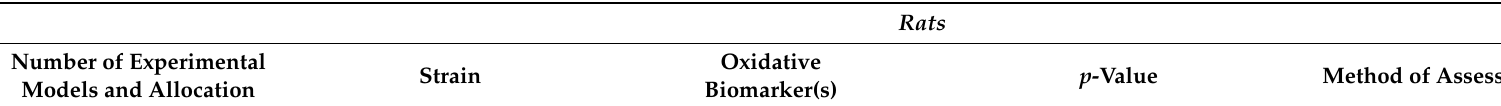
Method of Assessment